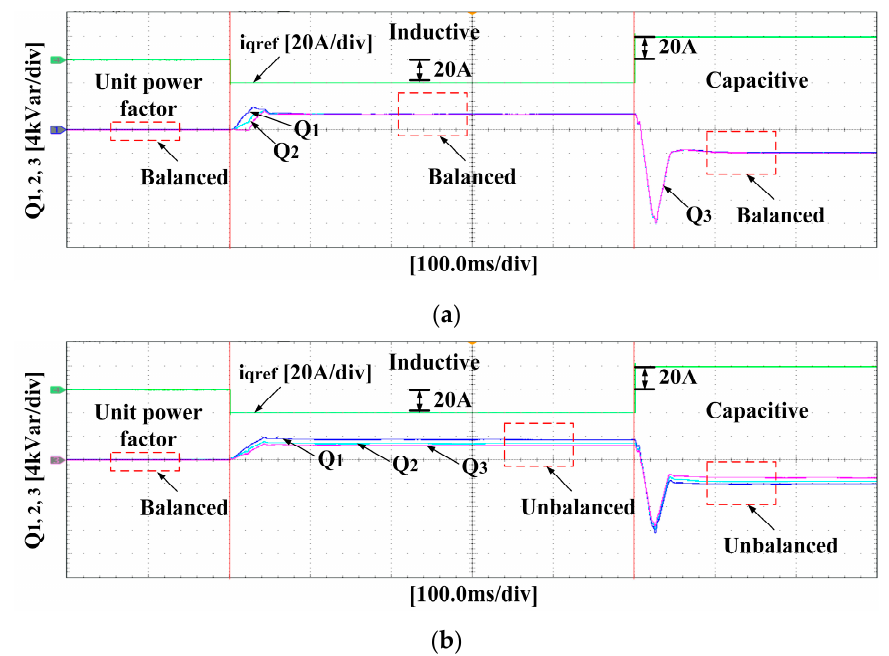
Figure 16. Experimental waveforms of the active power of the CHBR modules under different working conditions by use of ( a ) the proposed control strategy and ( b ) the conventional control strategy.